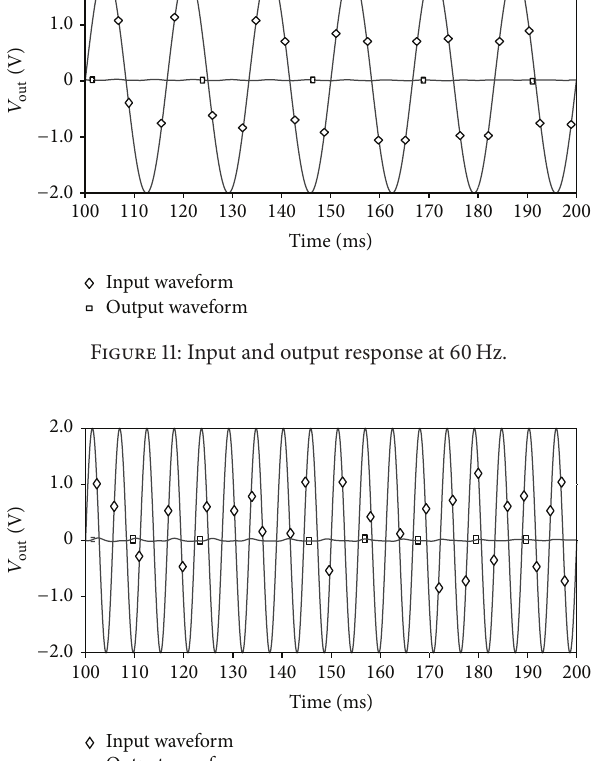
Figure 9: Frequency response of OTA transconductance for bias current 𝐼 𝐵 = 206.3 𝜇 A.